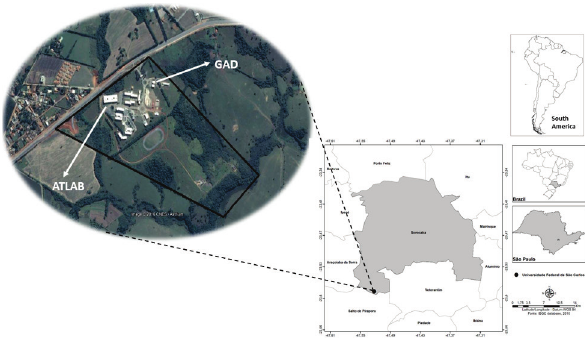
Figure 1. Location of the study area in Sorocaba, São Paulo,